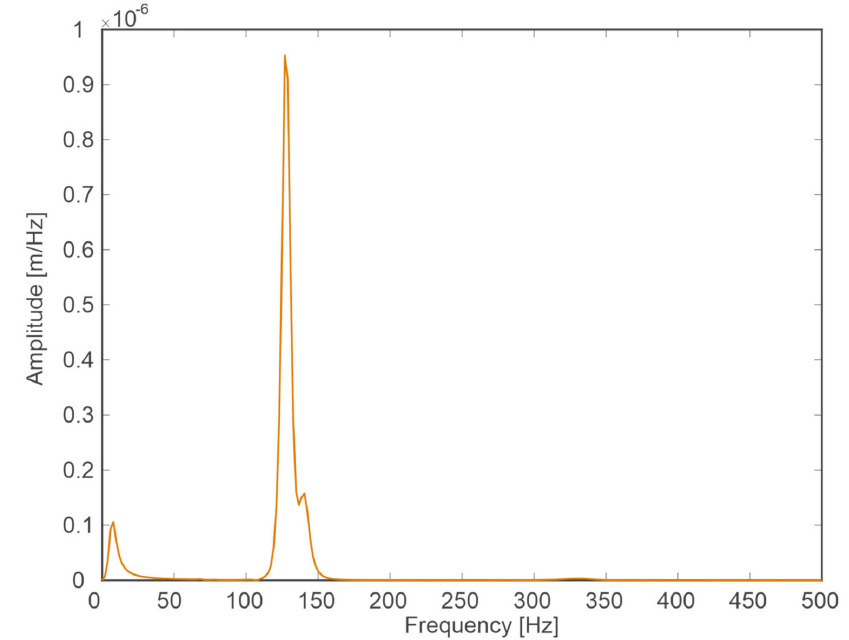
Figure 19. Spectrum generated from lateral displacement in the direction z of the capsule at a speed of 2000 km /